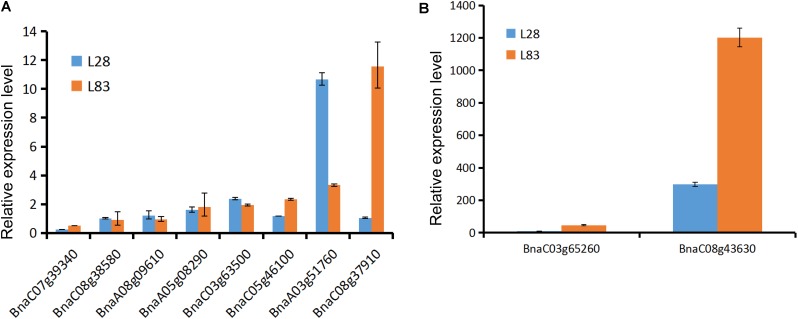
The genes expression level in two lines after exposure to Cd based on qRT-PCR. The y-axis represents Cd-induced expression fold change relative to control treatment. (A) The genes expression level less than 15 times in both lines. (B) The genes expression level more than 15 times in one or both lines.